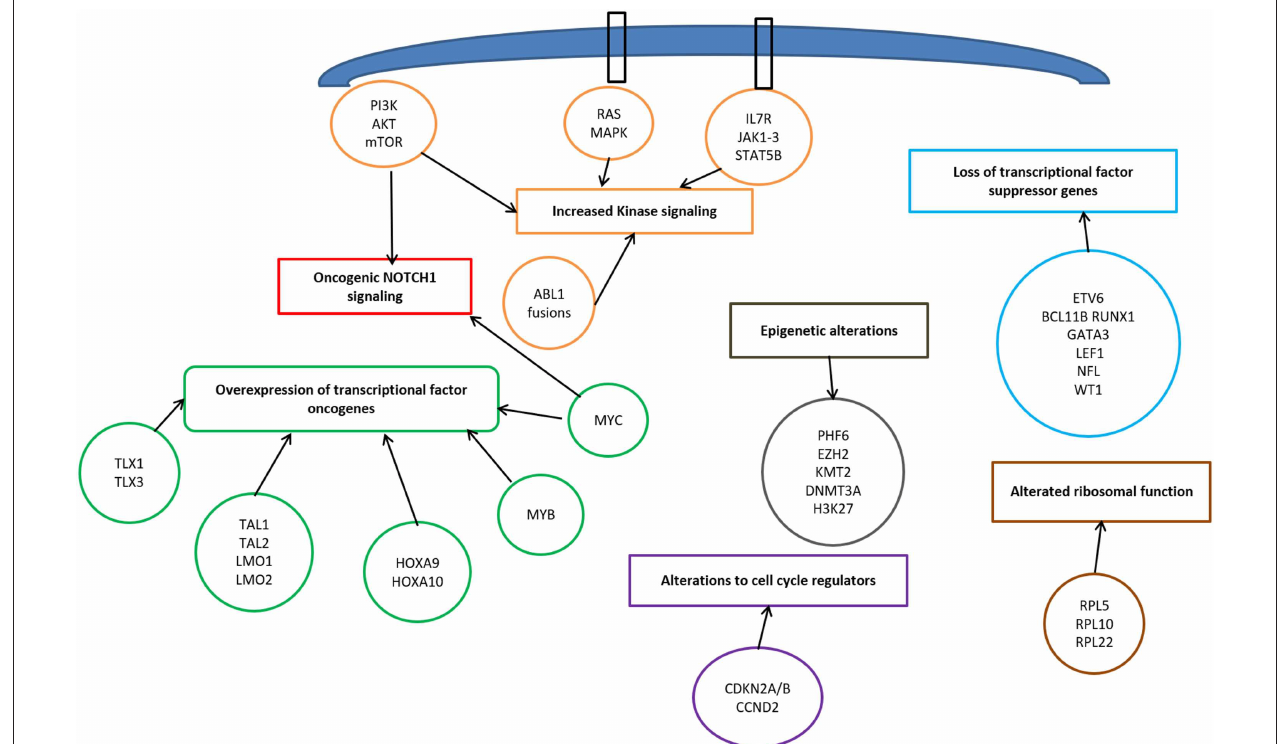
FIGURE 1 | Signaling pathways involved in T-cell acute lymphoblastic leukemia pathophysiology.